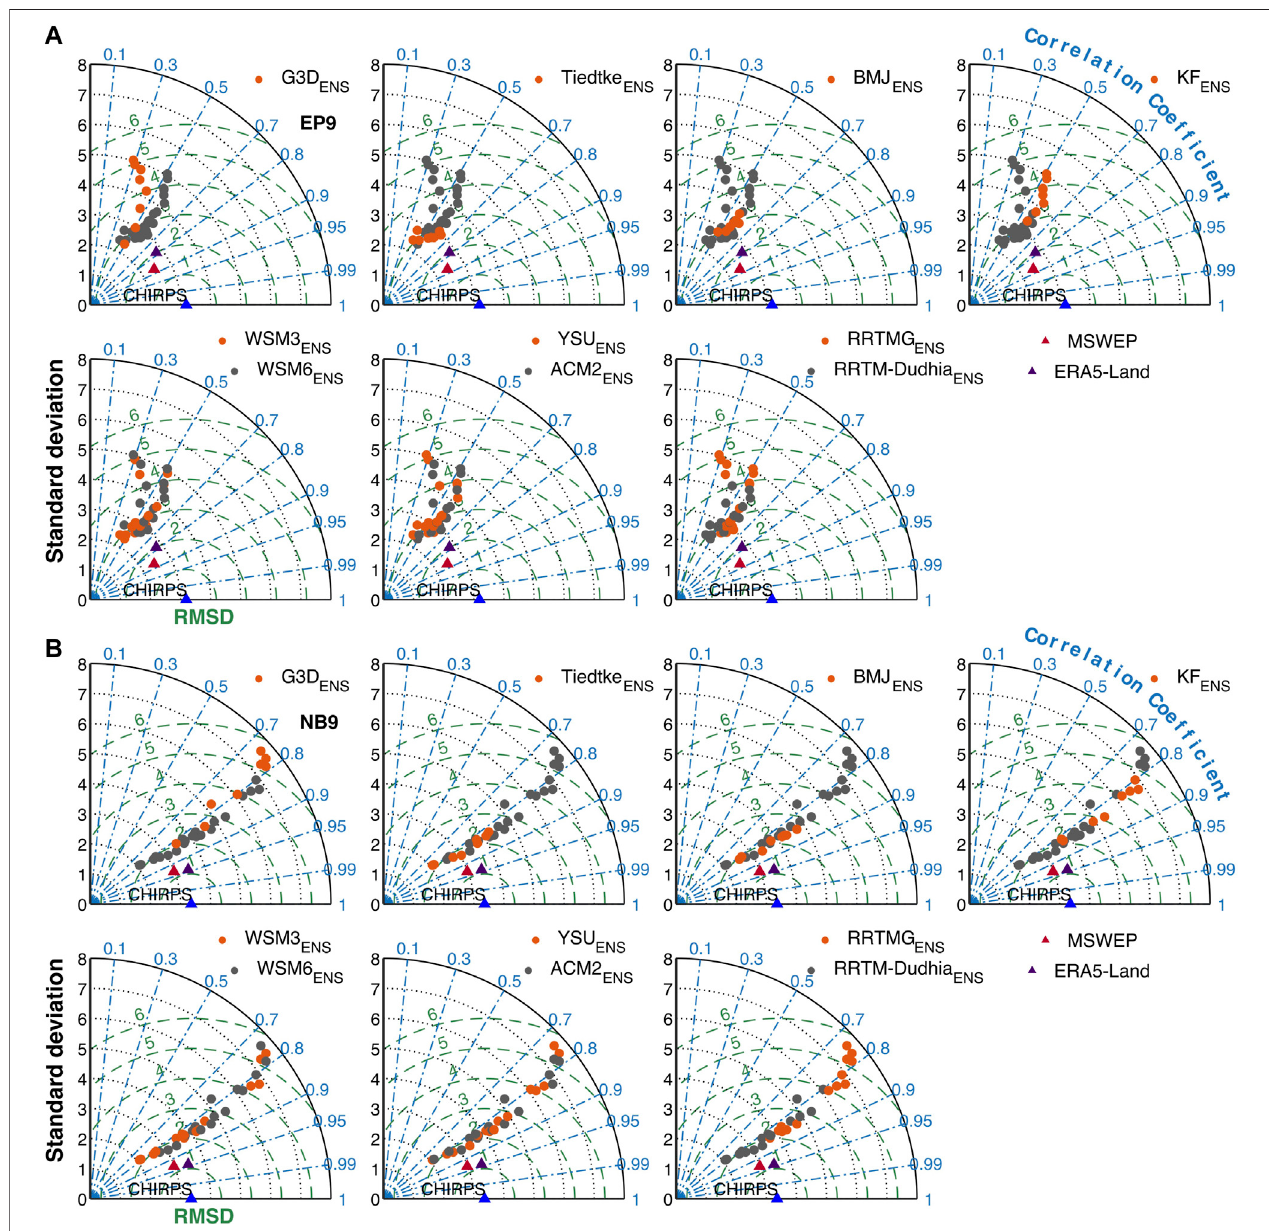
FIGURE 8 | Taylor diagram for (A) EP9 and (B) NB9 including the Pearson correlation coef fi cient (dashed-dotted lines), the standard deviation (dotted lines, in mm d − 1 ) and the root-mean-square difference (RMSD) of the anomalies (dashed lines, in mm d − 1 ) between the simulated daily precipitation timeseries of the 32 WRF physics ensemble members and CHIRPS reference data for the period Jan 2006 – Jun 2008. Each panel shows the differences in the physics parameterization sub- ensembles, i.e., cumulus convection (G3D, Tiedtke, BMJ, KF), microphysics (WSM3, WSM6), planetary boundary layer (YSU, ACM2), and radiation physics (RRTMG,